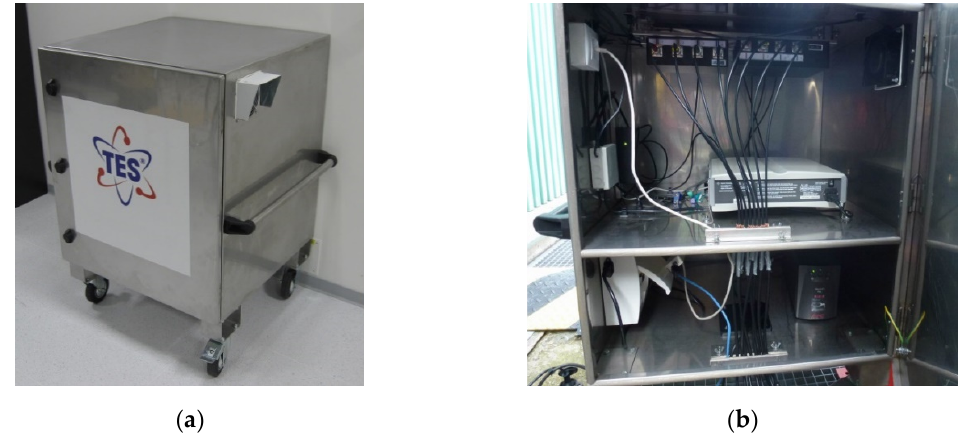
Figure 7. The main unit of the PD UHF diagnostic system: closed ( a ) and open ( b ) case views.